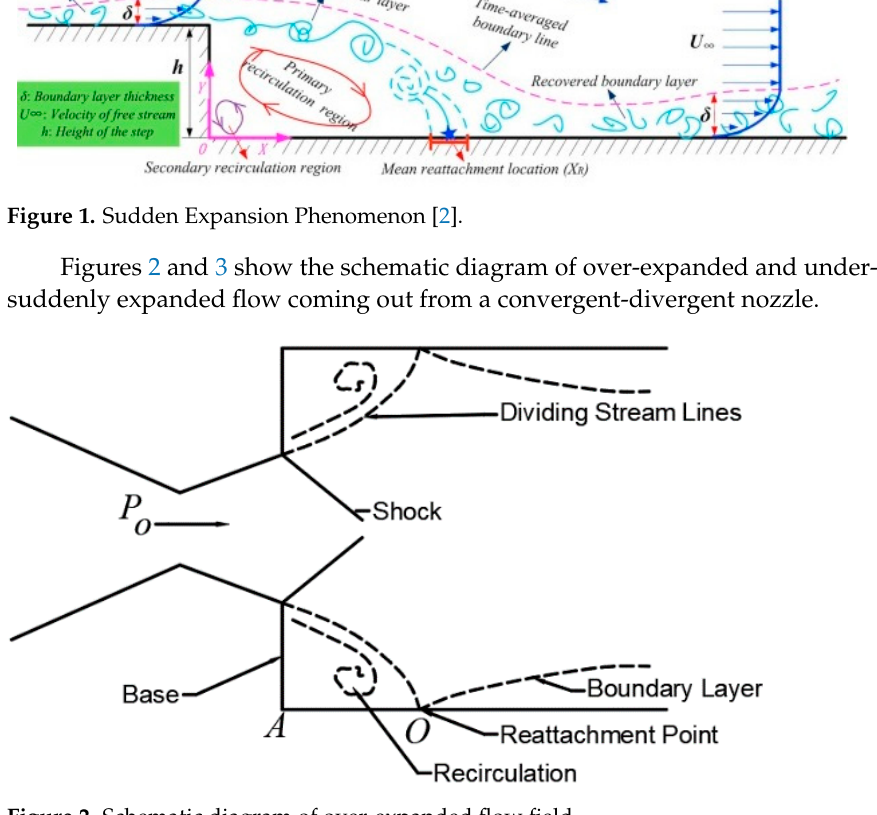
Figure 3. Schematic diagram of the under-expanded flow field. In the above Figure 4, the flow is coming from an upstream condition (P 1 M 1 d 1 ) to a downstream state (P 2 M 2 d 2 ). P b is the pressure at the base of the duct.